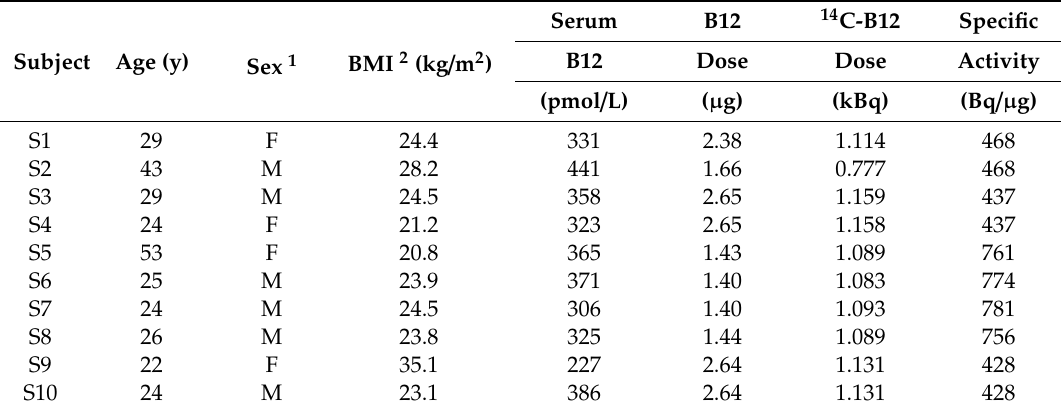
Table 1. Study subjects and